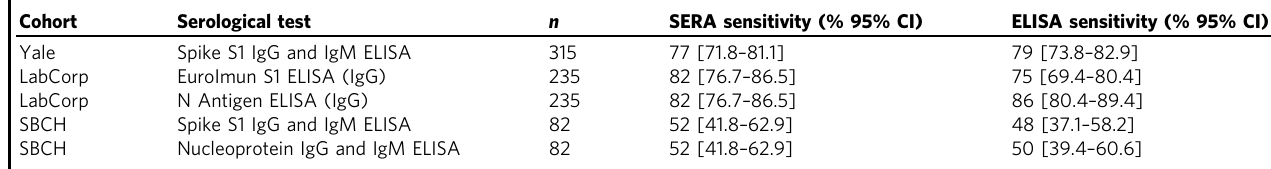
Table 2 SERA SARS-CoV-2 IgG or IgM panel sensitivity as compared with various ELISAs in NAT positive subjects. Cohort Serological